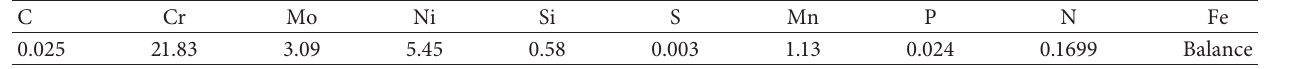
Table 1: Chemical composition of 2205 duplex stainless steel (wt%).